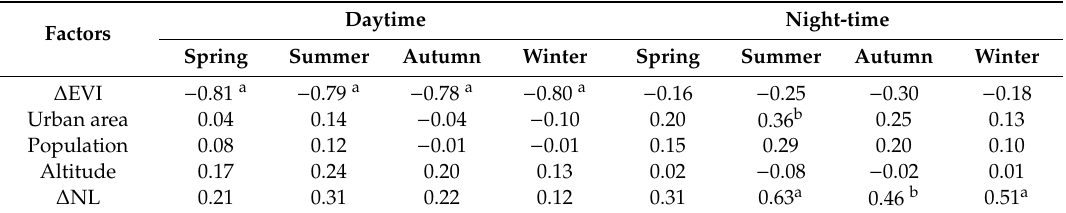
Table 4. Correlations between SUHII and the di ff erence in the enhanced vegetation index ( ∆ EVI), urban area, population, altitude, and ∆ NL during the daytime and night-time, for each season. Daytime Night-time Factors Spring Summer Autumn Winter Spring Summer Autumn Winter ∆ EVI − 0.81 a − 0.79 a − 0.78 a − 0.80 a − 0.16 − 0.25 − 0.30 − 0.18 Urban area 0.04 0.14 Population Altitude 0.17